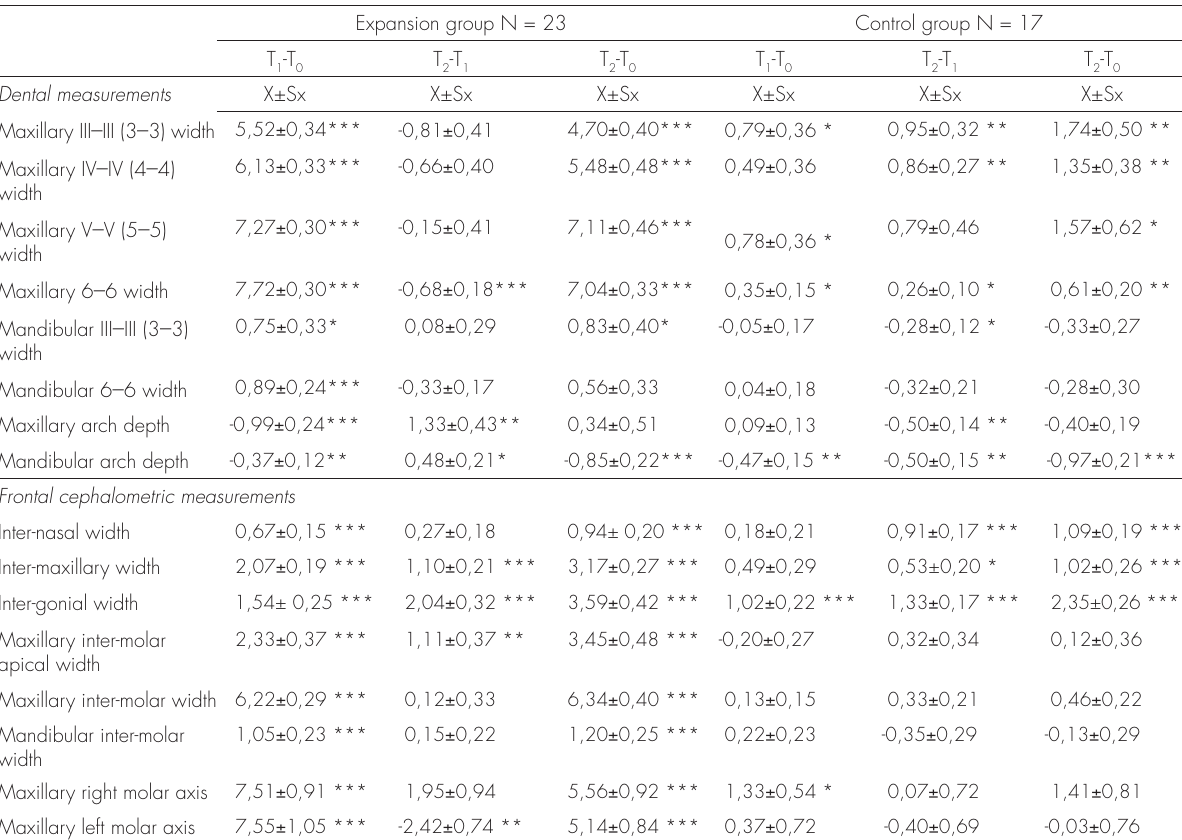
Table II. The changes in values of dental cast and frontal radiographic measurements during different